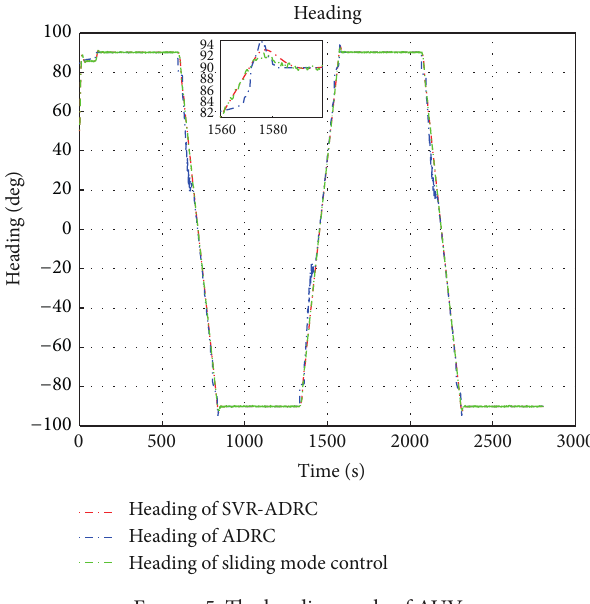
Figure 5: The heading angle of AUV.